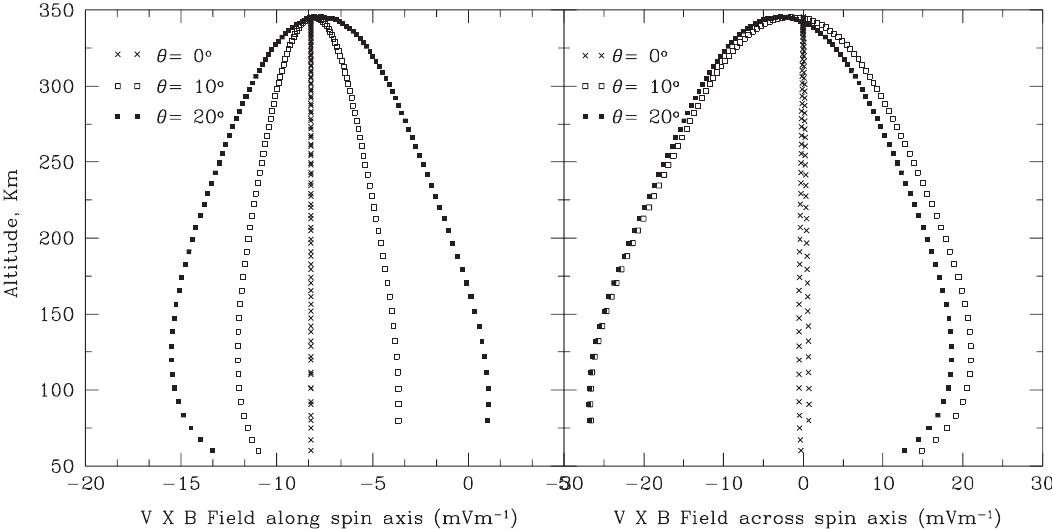
Fig. 3. Electric field induced due to the V · B e(cid:128)ect along the spin axis ( left panel ) and across the spin axis ( right panel ) for three values of h , which is the angle between the spin axis and